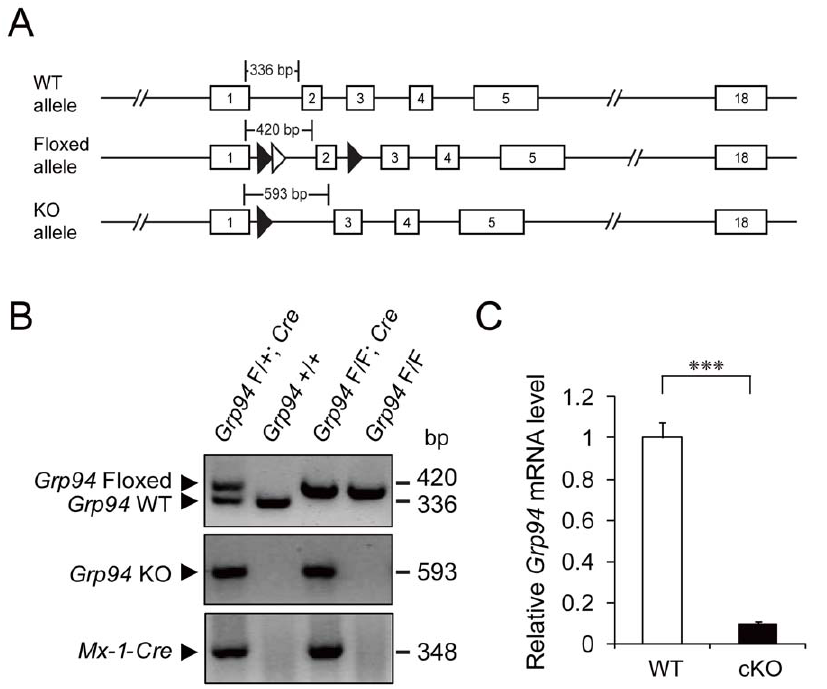
Figure 1. Conditional knockout of Grp94 in the bone marrow. A) Schematic drawings of the Grp94 wild-type (WT) allele, the floxed allele and the knockout (KO) allele. The exons are boxed and numbered. The loxP sites (closed triangle) and the FRT site (open triangle) and expected PCR products for genotyping is indicated. B) Representative BM PCR genotyping results of mice with indicated genotypes after pI.pC injection. C) Grp94 mRNA expression measured by quantitative real-time PCR from WT (n=16) and cKO (n=18) mouse BM after pI.pC injection. The level of Grp94 mRNA was normalized against the level of internal control 18S RNA . The data are presented as mean 6 s.e., ***p , 0.001.